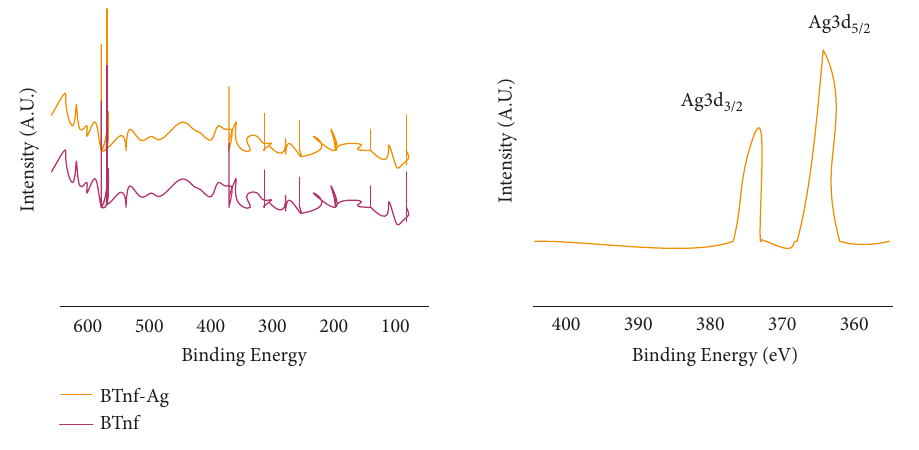
Figure 5: X-ray photoelectron spectra of BTnf and BTnf-Ag Ag3d